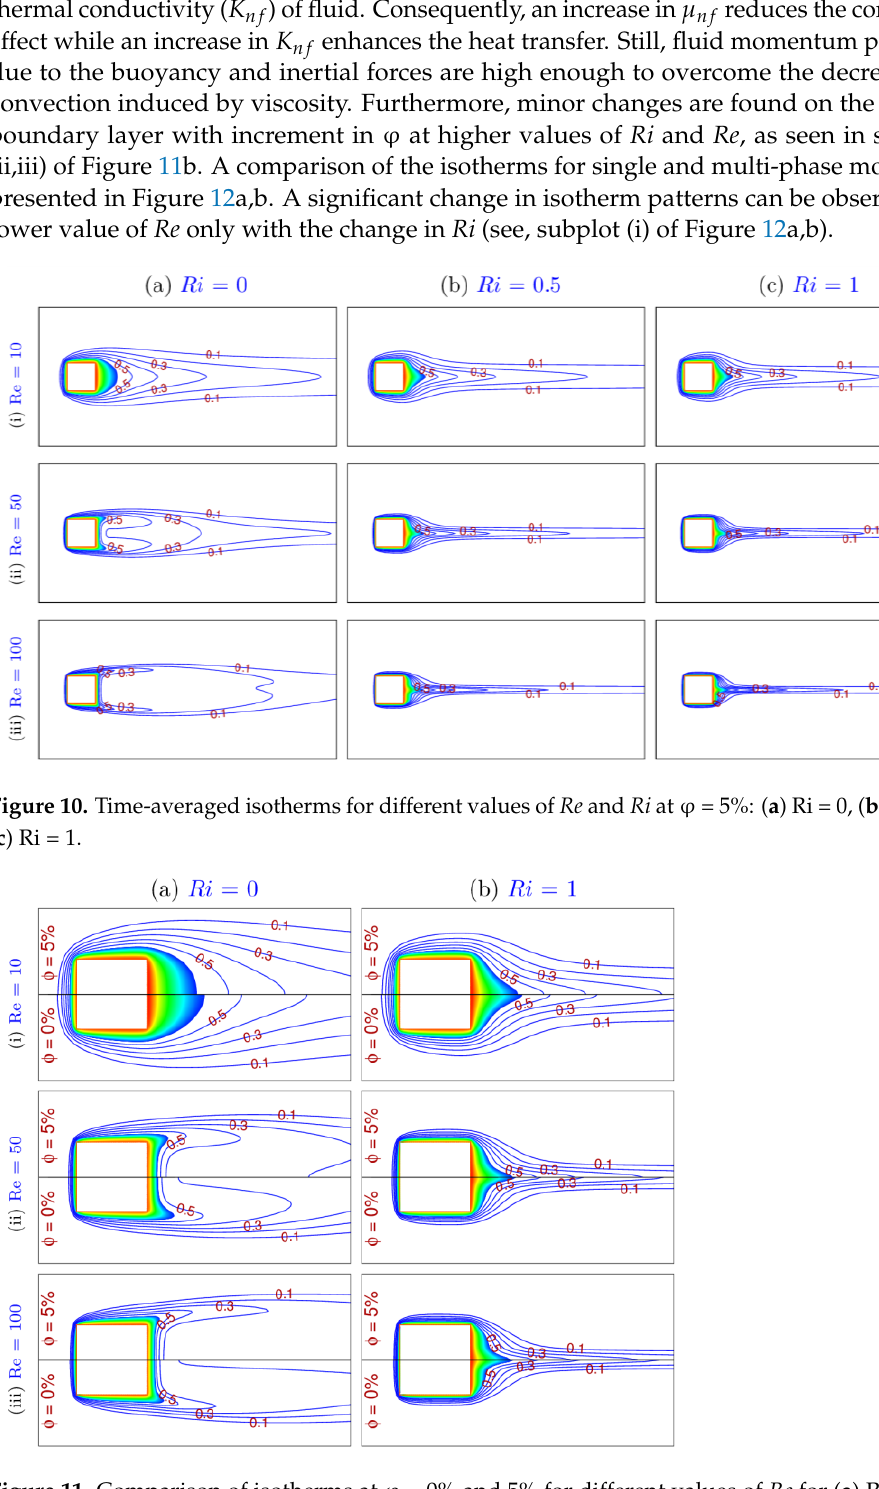
Figure 11. Comparison of isotherms at ϕ = 0% and 5% for different values of Re for ( a ) Ri = 0 and ( b ) Ri =